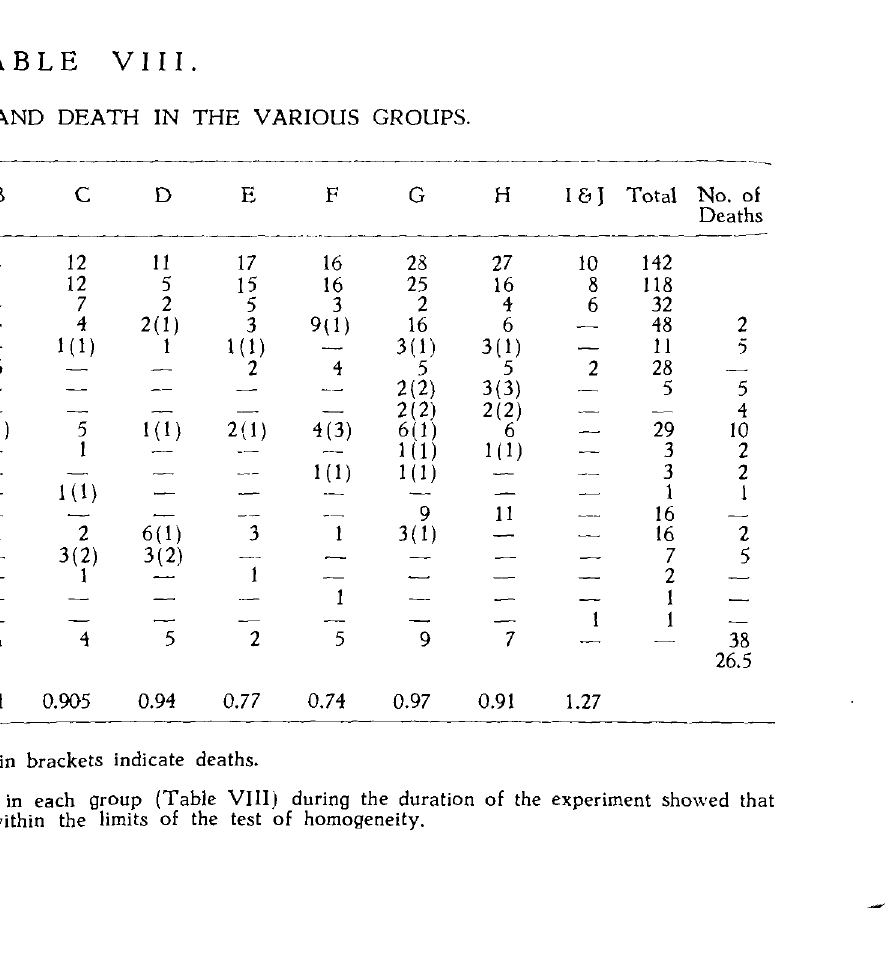
INCIDENCE OF DISEASE AND DEATH IN THE VARIOUS